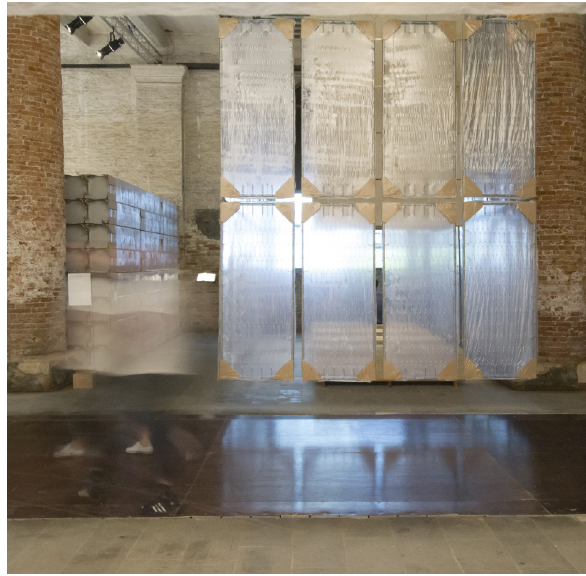
Figure 5. “Theater of the UseFULL”, Rural Studio,